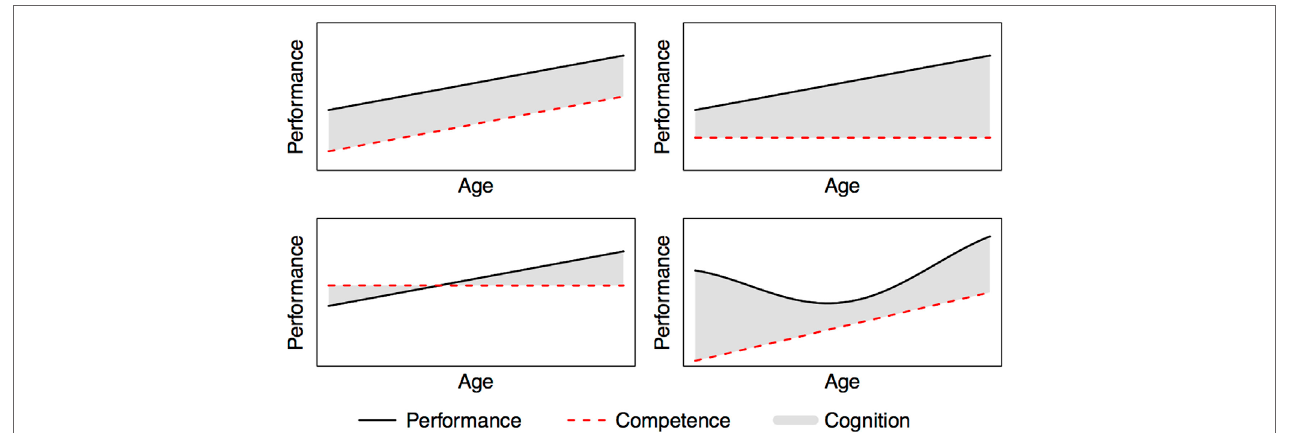
FigURe 1 | The above graphs show four possible relationships between competence, cognition and performance. Performance is influenced by competence and cognition. If someone’s performance (black solid line) increases over age, this could be due to the competence (red dashed line) increasing (as displayed in the upper left graph), or due to cognition (shaded area) increasing, while competence stays constant (as displayed in the upper right graph). Cognitive limitations can prevent performance from reaching full competence (lower left graph). Competence and cognition can also both change over age and influence performance. The lower right graph shows the classical performance curve of U-shaped learning, in which performance initially decreases even though competence is increasing. The graphs are a simplification, as factors other than competence and cognition could also influence performance, for example motor